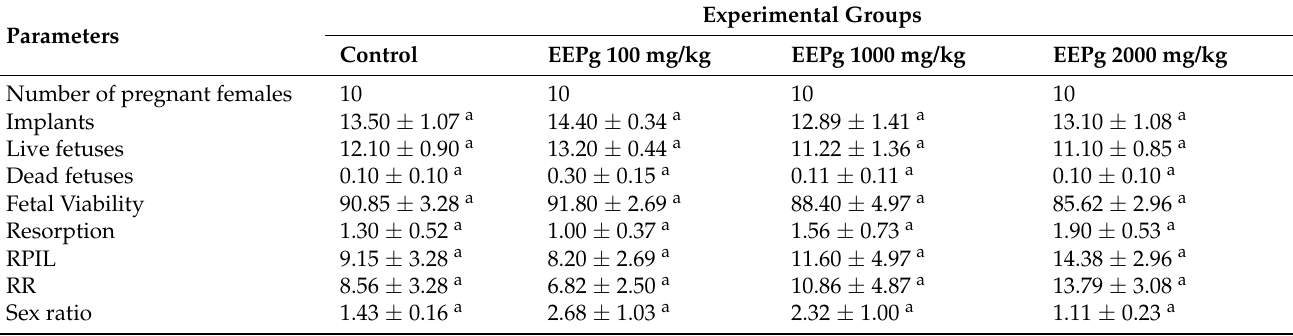
Table 3. Mean values ± standard error of mean parameters related to reproductive performance of females treated with ethanolic extract of P. glabratum